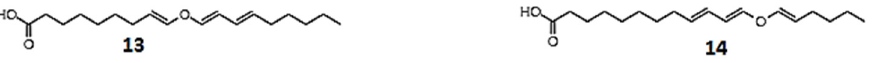
Figure 3. Chemical structures of plant oxylipins, divinyl ether fatty acids: colneleic acid ( 13 ) and etheroleic acid ( 14 ).